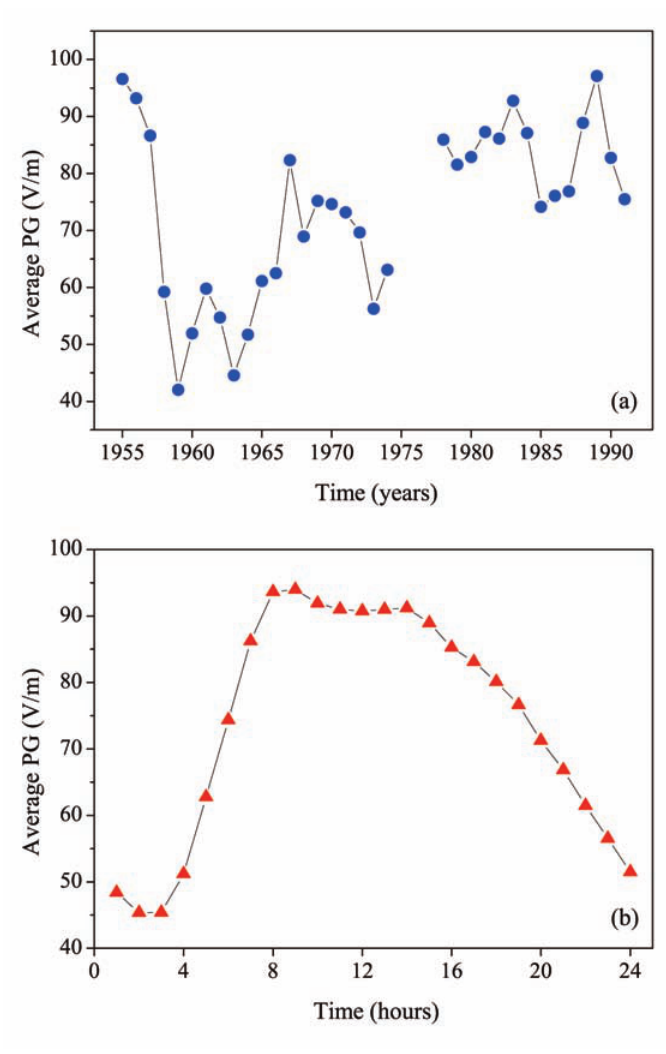
Figure 1. a) Average PGs per year during the period from 1955 to 1991 at Portela (Lisbon, Portugal). b) The diurnal cycle of the PGs averaged over all of the data.